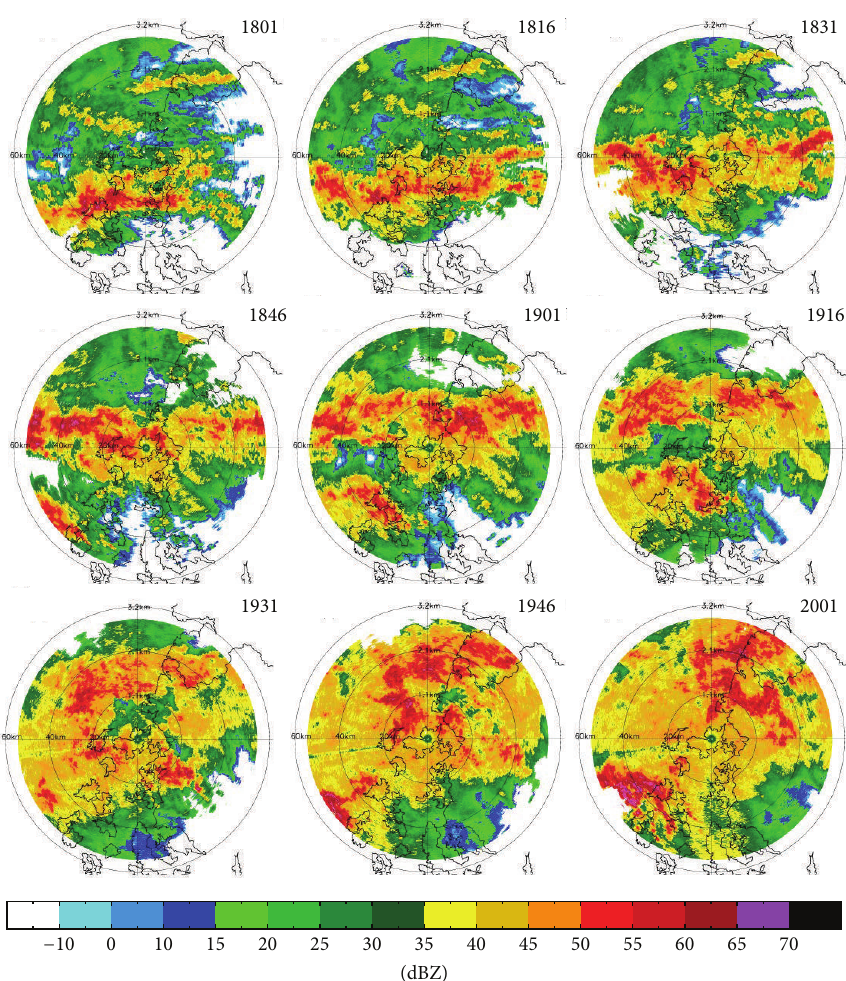
Figure 2: PPI images of attenuation corrected 𝑍 𝐻 from 1801UTC, July 10, 2010, with an interval of 15 min.